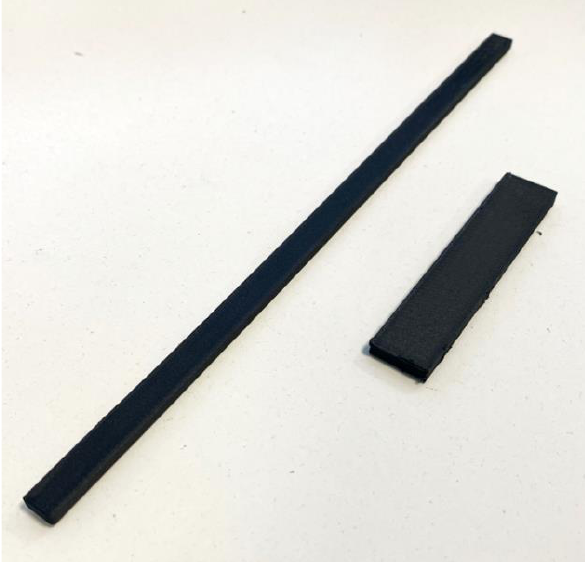
Figure 3. Samples for tensile (left) and bending (right) tests.